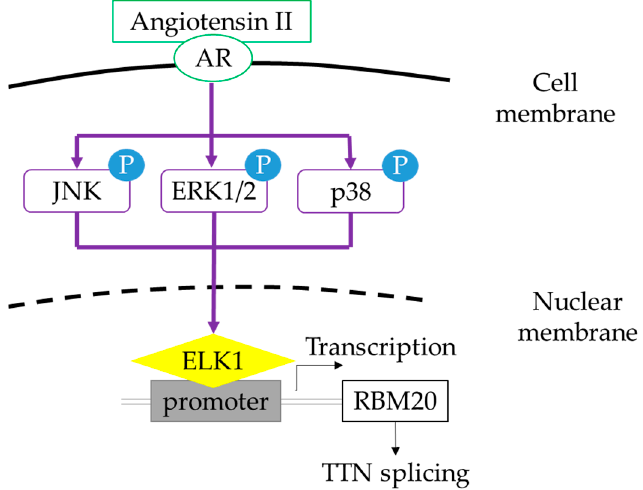
Figure 6. Schematic diagram depicting the MAPK / ELK1 signaling pathway linking Ang II-RBM20-titin splicing. Ang II activates and phosphorylates three signal molecules, JNK, ERK1 / 2, and p38 in the MAPK signaling pathway, and then activates the expression of ELK1. ELK1 regulates the transcriptional and mRNA expression of RBM20 , which regulates pre-mRNA splicing of titin. AR, Angiotensin II receptor.